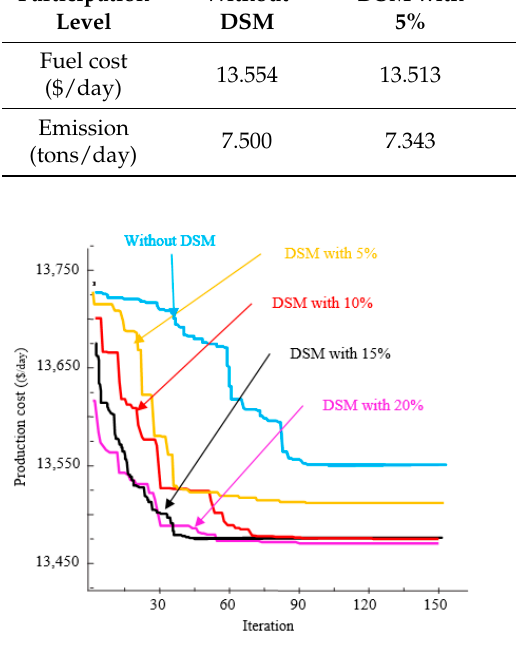
Table 2. Dynamic economical dispatch with various participation levels of DSM.